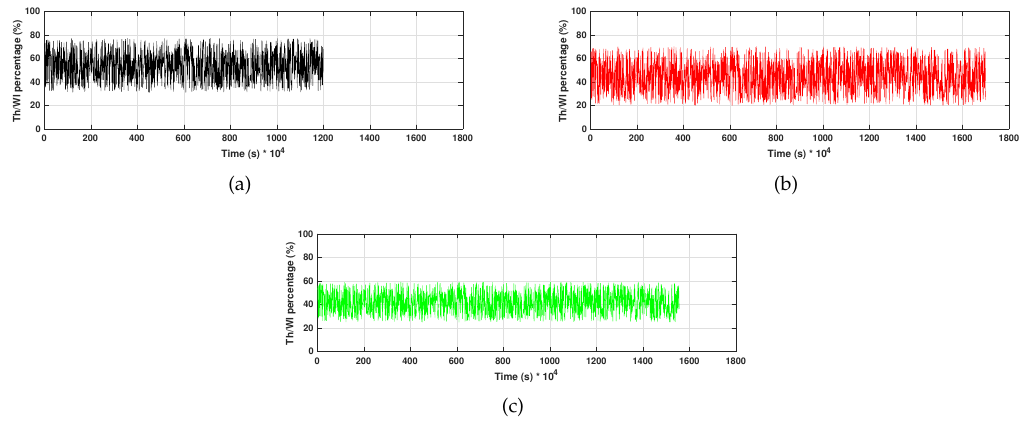
Figure 8. Th / Wl performance: ( a ) without FLC; ( b ) FLC with Trapezoidal MFs; ( c ) Wang et al.